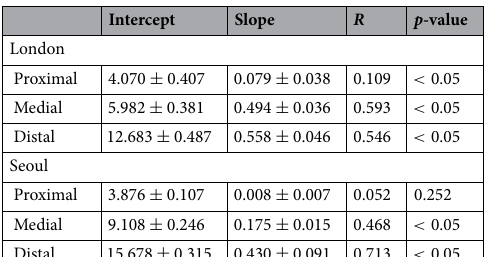
p ˆ µ m ˆ µ d i , i , i from the